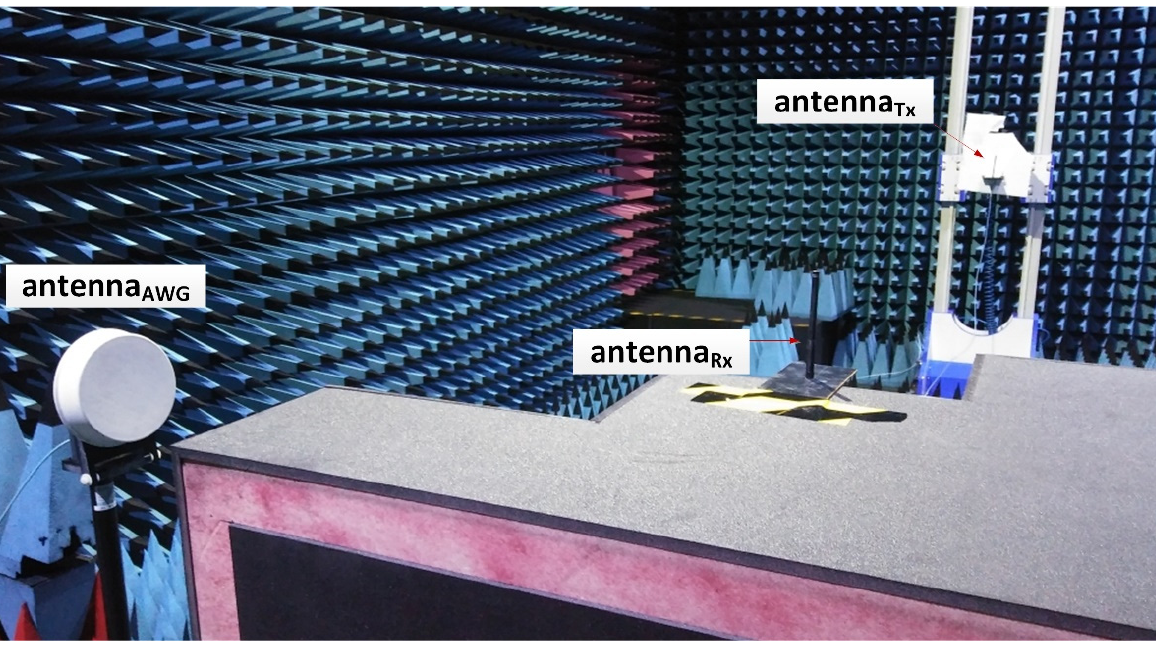
Figure 6. DUT devices in anechoic chamber.